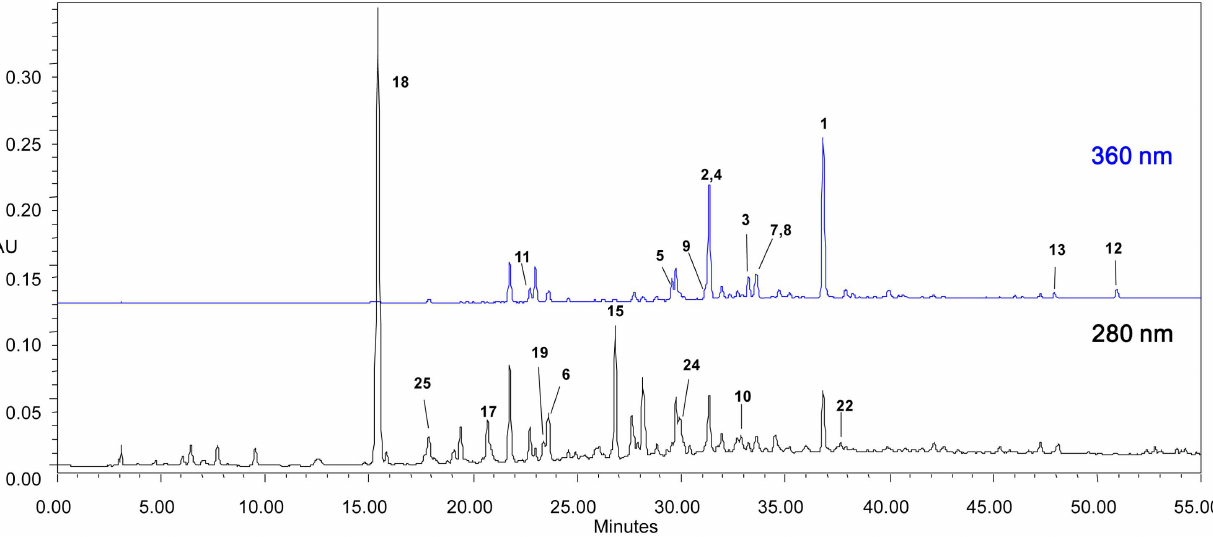
Figure 2. HPLC-PDA chromatogram of mulberry fruit ( Morusalba L.) polyphenol enhanced extract.